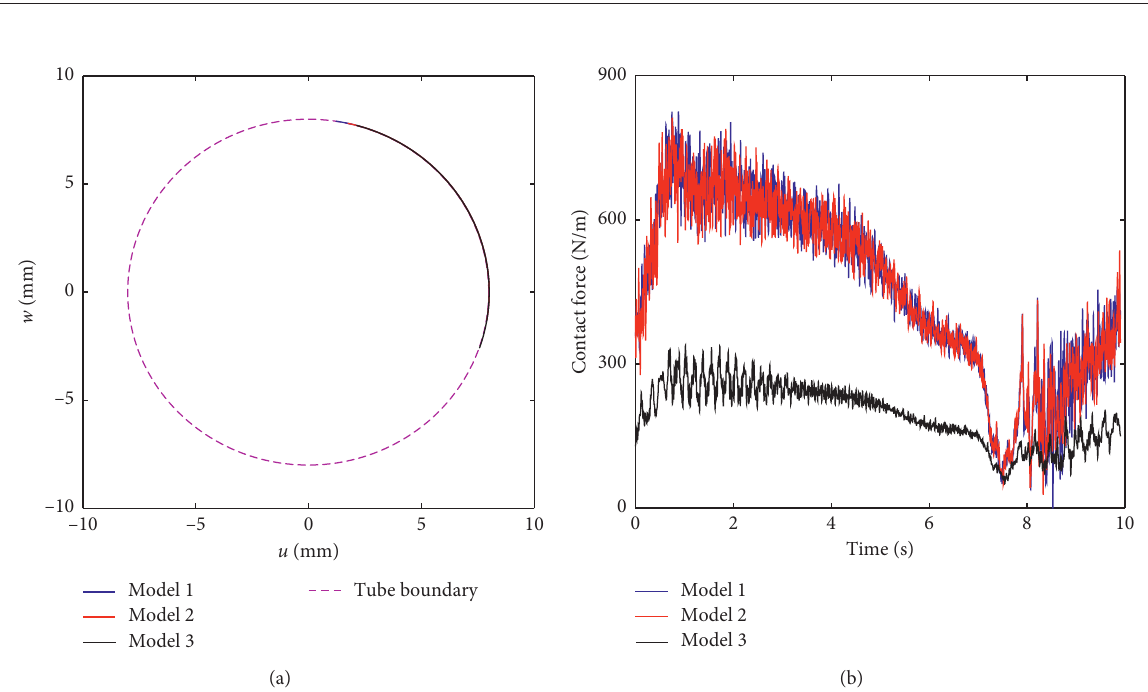
Figure 10: Simulation results of the coupling node at 531m. (a) Node position. (b) Contact force between the rod and